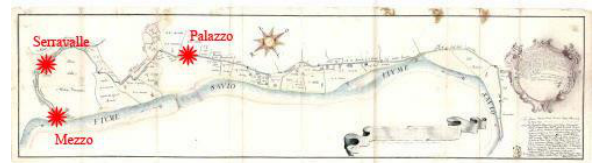
Figure 5. The Cesuola channel and a portion of Savio river in a map dating back to 1757 (MiBACT, 2015). The location of three mills represented here is highlighted in red